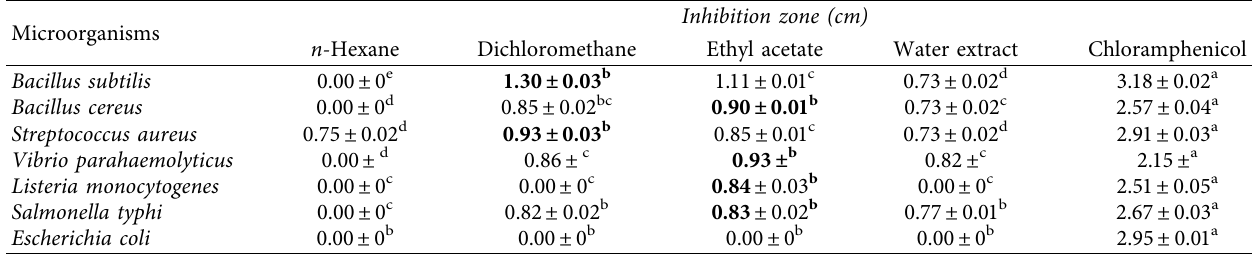
Table 3: Antibacterial of S. palustris (Burm.f.) Bedd. extracts at a concentration of 500 μ g/disc for Gram-negative and Gram-positive